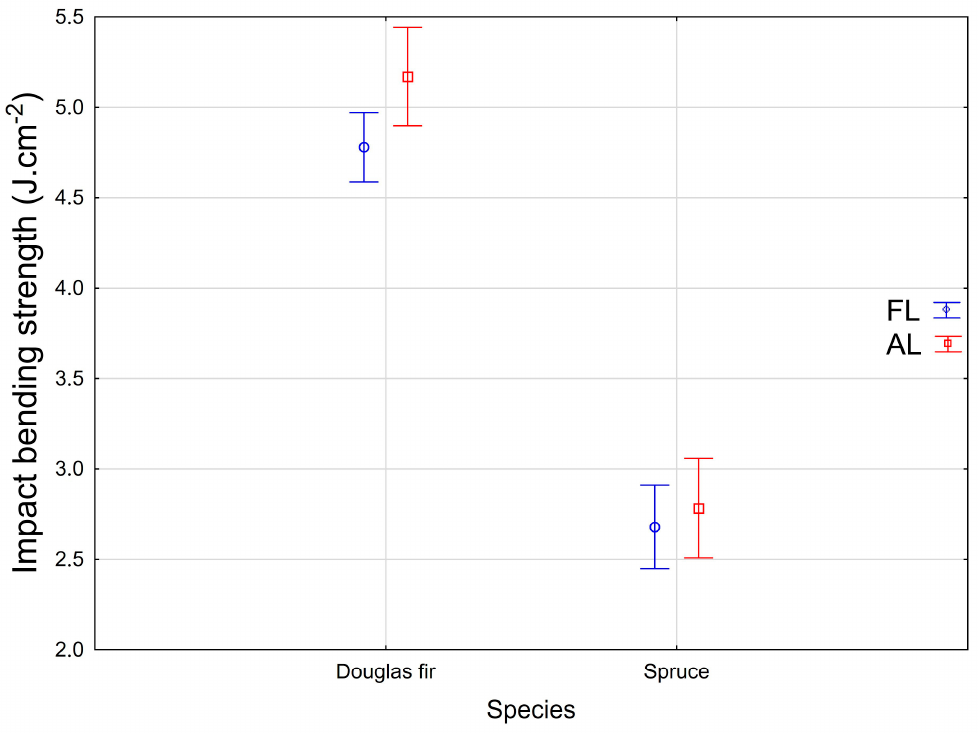
Figure 4. Impact of site on impact bending strength.